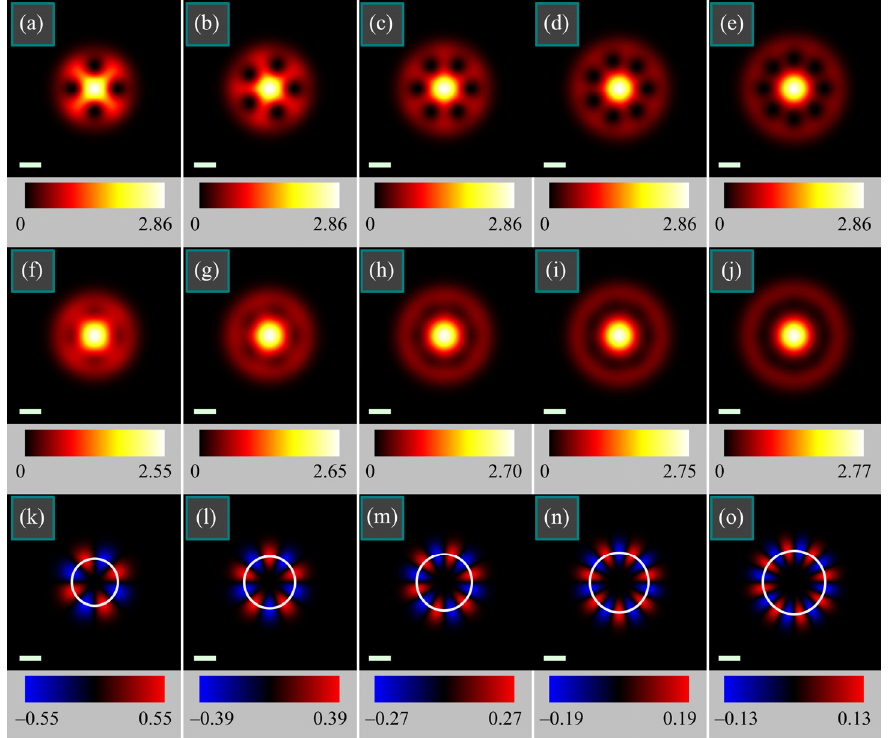
Figure 8. Intensity distributions in the initial plane ( a – e ) and at the maximal-SAM distance (33) ( f – j ), as well as SAM density distributions at the maximal-SAM distance ( k – o ) for the following parameters: wavelength λ = 532 nm, Gaussian beam waist radius w 0 = 1 mm, number of the polarization singularities in the initial plane m = 4 ( a , f , k ), m = 5 ( b , g , l ), m = 6 ( c , h , m ), m = 7 ( d , i , n ), m = 8 ( e , j , o ), radius of the singularities circle a 0 = 1052 µ m ( a , f , k ), a 0 = 1141 µ m ( b , g , l ), a 0 = 1223 µ m ( c , h , m ), a 0 = 1300 µ m ( d , i , n ), a 0 = 1371 µ m ( e , j , o ), propagation distance is z = 0.349 z 0 ( a , f , k ), z = 0.284 z 0 ( b , g , l ), z = 0.240 z 0 ( c , h , m ), z = 0.208 z 0 ( d , i , n ), z = 0.183 z 0 ( e , j , o ). The radii a 0 were computed by Equation (34) to maximize the SAM over all other radii a 0 . Propagation distances were computed by Equation (33) to maximize the SAM density. Circles on the SAM distributions ( k – o ) show the maximal-SAM radii obtained by Equation (25). All quantities (maximal intensity and SAM magnitude) are given in arbitrary units. Scale mark in each figure denotes 1 mm.